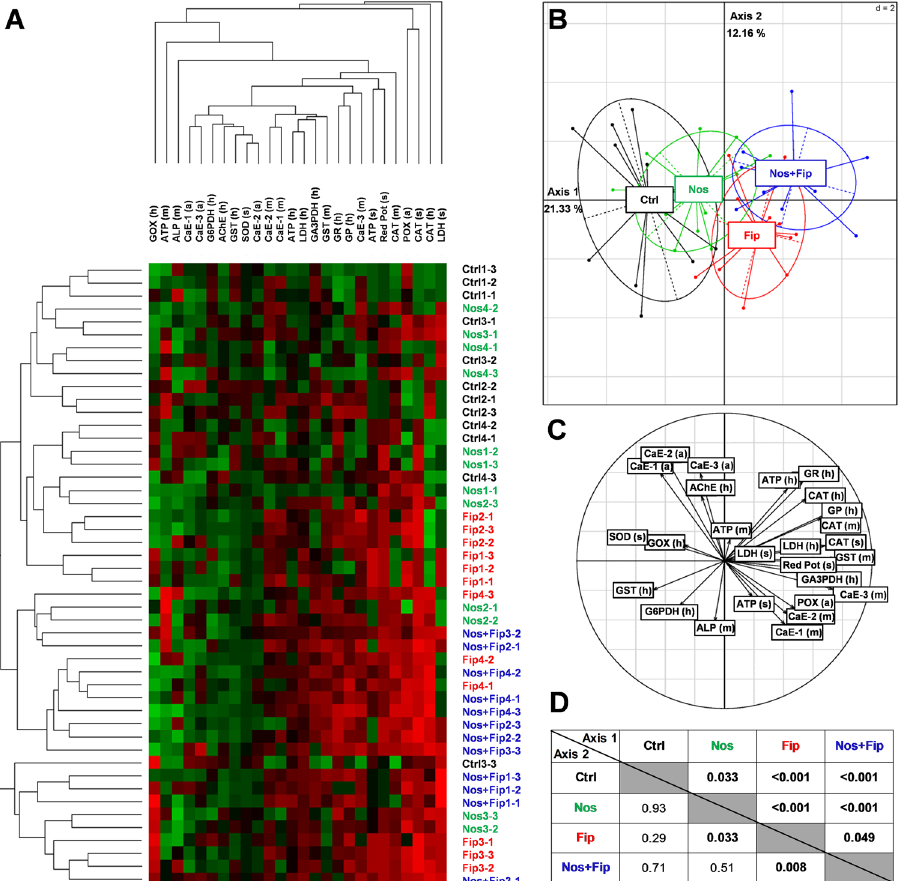
Figure 5. Effects of the stressors, alone or combined, on the physiological state of drones including semen. The cluster analysis (hierarchical clustering results) after optimal reorganization 100 ( A ) and the principal component analysis ( B ) show an integrative approach to assess the physiological markers studied in the head (h), midgut (m), abdomen (a) and semen (s) of drones. A color code is assigned to each treatment: “black” for the control group (Ctrl), “green” for the N. ceranae group (Nos), “red” for the fipronil group (Fip), and “blue” for the N. ceranae /fipronil group (Nos + Fip). In the cluster analysis, the first number indicates the hive, and the second number indicates the sample. The intensity of modulation in the clusters is illustrated by the range of colors, with green and red indicating that a physiological marker was downregulated or upregulated, respectively, in comparison with the mean value in the controls. Black indicates no change in comparison with the mean value in the controls. The correlation circle (C) indicates the significance of the markers in the PCA representation. For statistical analysis, a post-hoc Wilcoxon test was applied on the values of the two main axes of the PCA. P values are indicated in the table ( D